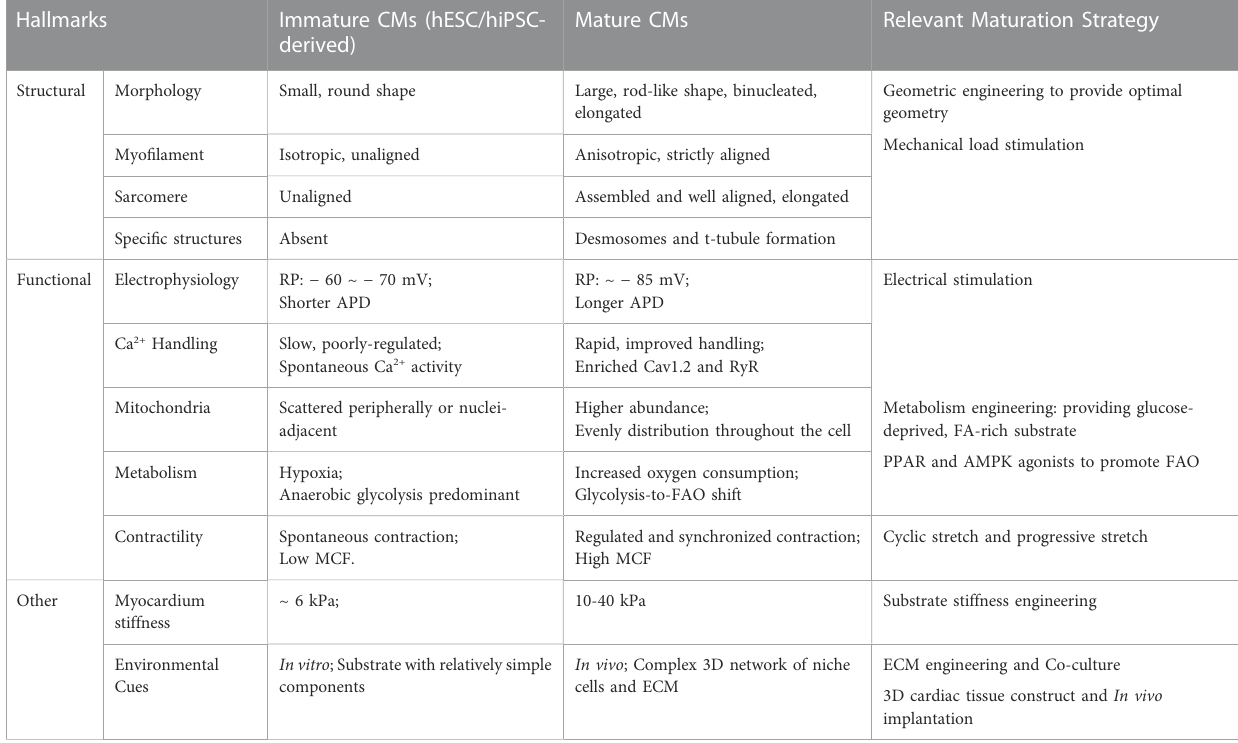
TABLE 1 Major differences between immature and mature CMs, and matching maturation strategy.